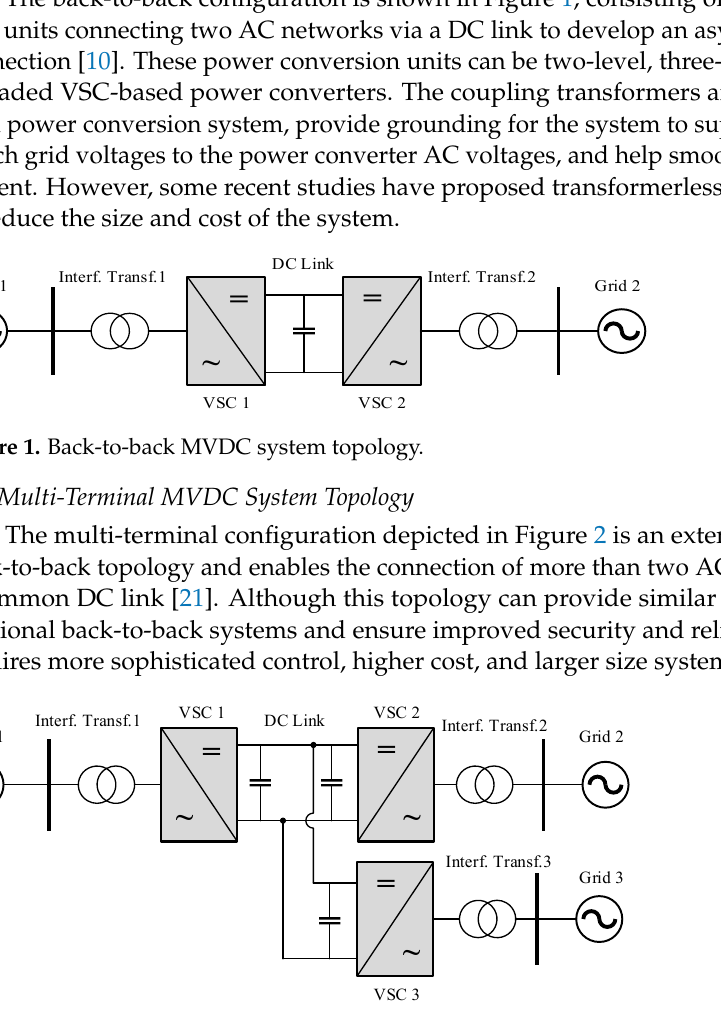
Figure 2. Multi-terminal MVDC system topology.